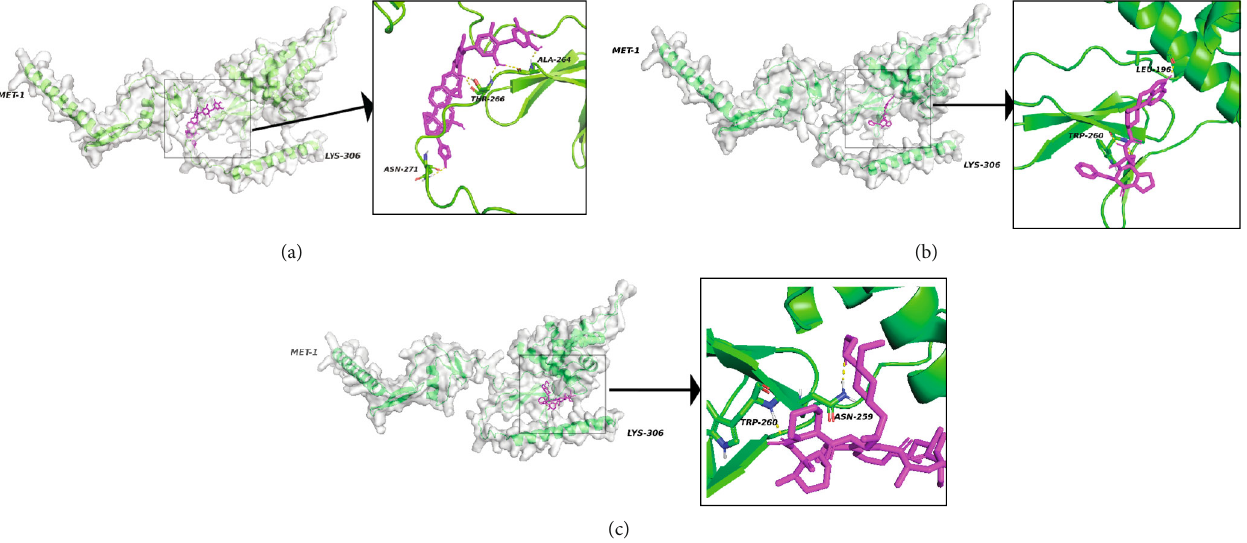
Figure 8: Molecular docking results for ZINC242548690, ZINC3978005, and ZINC169677008. (a) 3D view of the best selected conformation of FSTL1-ZINC242548690. (b) 3D view of the best selected conformation of FSTL1-ZINC3978005. (c) 3D view of the best selected conformation of FSTL1-ZINC169677008. Green color: FSTL1; purple color: small molecules; yellow color: conventional hydrogen bonds.